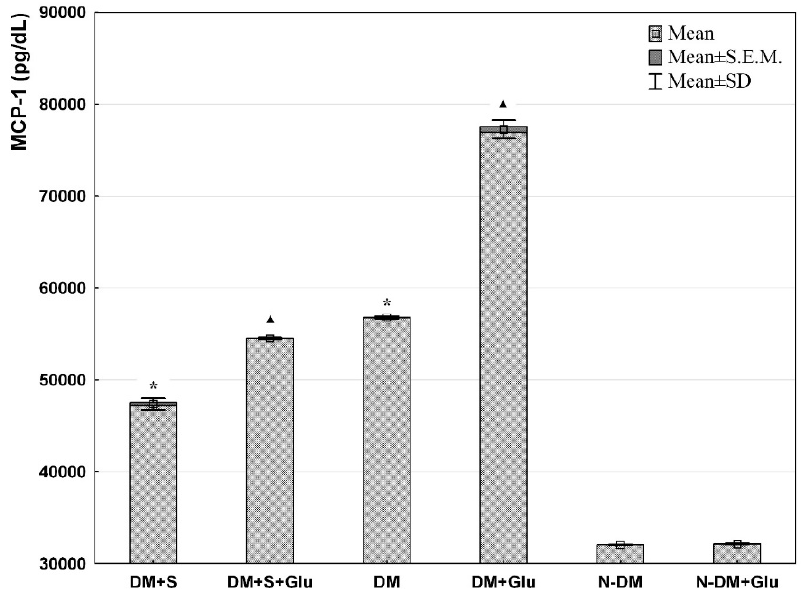
Figure 2. MCP-1 level in the supernatant from a culture of human PBMCs isolated from statin- treated or statin-free type 2 diabetic patients, or from non-diabetic controls in the medium only, or preincubated with glucose (ANOVA). *—statistically significant difference compared with other groups at basic conditions, for p ≤ 0.05 ; ▲ —statistically significant difference compared with other groups in the presence of glucose, for p ≤ 0.05.